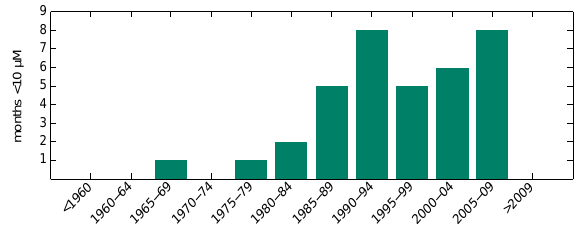
Figure 7. Increasing number of months with oxygen concentrations in 25 m depth below 10µ molL − 1 at BE in 5 year periods. Note that in the periods 1970–1974 and 1980–1984, measurements were not continuously available.